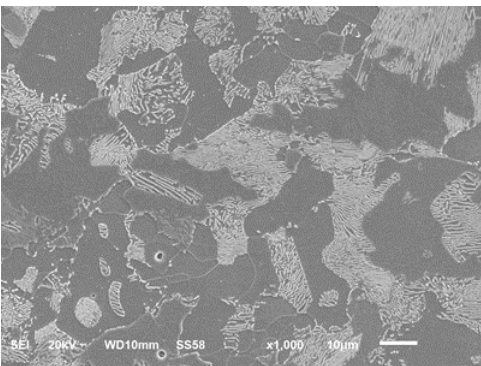
Figure 1. Tensile stress–strain curves.